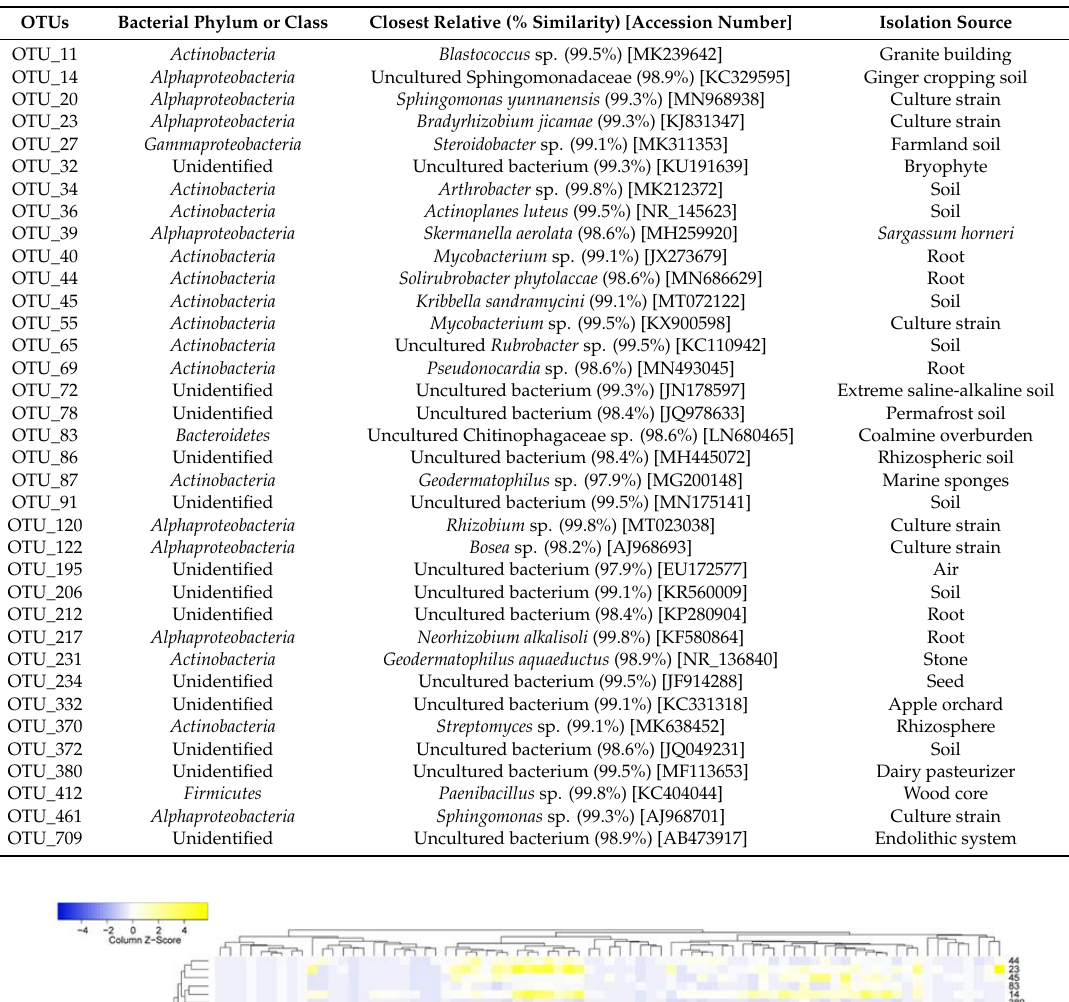
Table 3. The OTUs identified as being rhizosphere generalists in the three sampling areas (Santorini Island, Seich-Sou Forest and the National Park of Delta Axios), their putative high-level taxonomic a ffi liation, their closest relatives based on BLAST searches against the SILVA database and confirmed against NCBI database, and the isolation source of the closest relative.